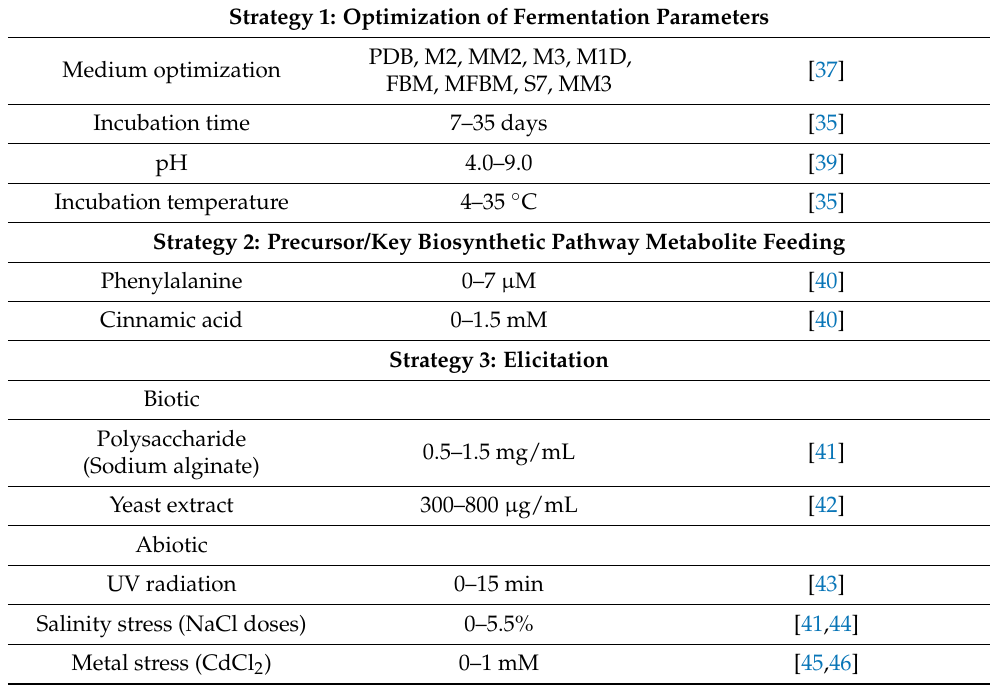
Table 1. Strategies used for chrysin